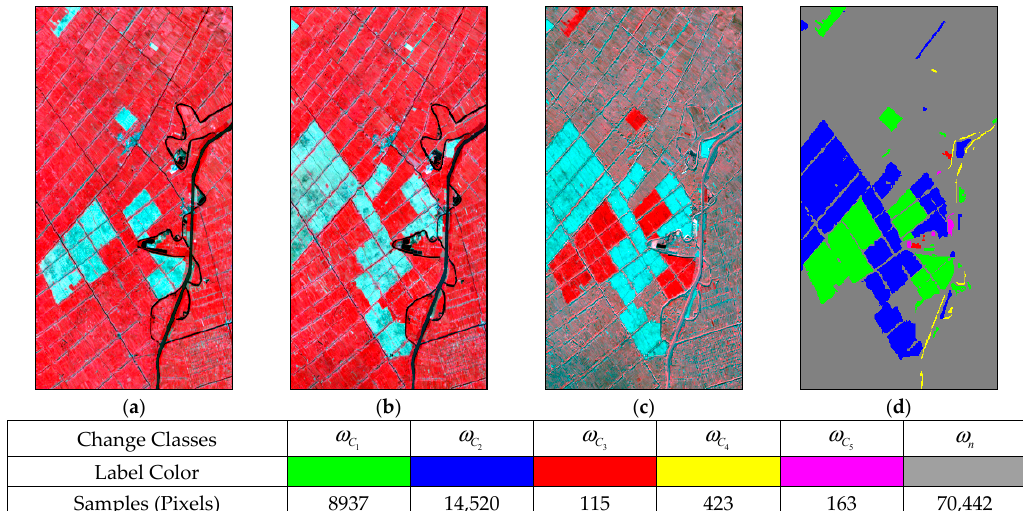
Figure 4 . False color composite (R: 752.4254 nm, G: 650.6727 nm, B: 548.9194 nm) of the bi-temporal EO-1 Hyperion images acquired over a wetland agricultural area in Yancheng (China) in ( a ) 2006 ( X 1 ) and ( b ) 2007 ( X 2 ); ( c ) composite of three SCV channels; ( d ) change reference map. Five changes are in different colors, whereas the unchanged pixels are in gray. Table 2. Number of class training samples used in the supervised CD approaches (Yancheng dataset).